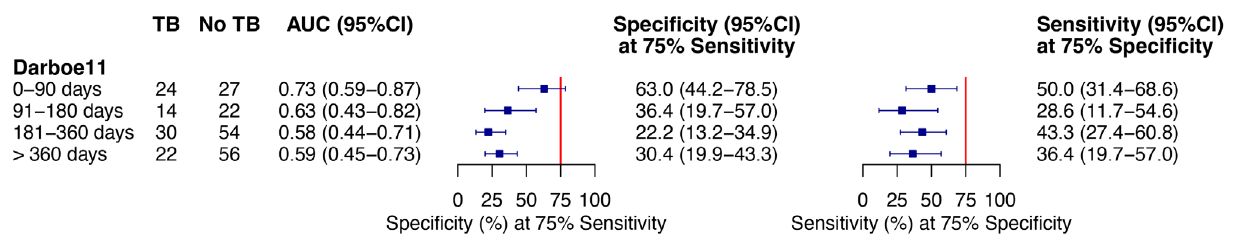
Figure 6. Transcriptomic signature prognostic performance for microbiologically confirmed TB disease. Darboe11 transcriptomic signature prognostic performance for microbiologically confirmed recurrent TB disease in the TB Recurrence upon Treatment with HAART (TRuTH) cohort (Darboe2019) 42 . Signature prognostic performance (area under the curve, AUC) is stratified by time window following completion of TB treatment: 0–90, 91–180, 181–360, and >360 days. Sensitivity and specificity benchmarked against the WHO TPP minimum performance criteria for a prognostic test (75% sensitivity and 75% specificity, red vertical lines) 18